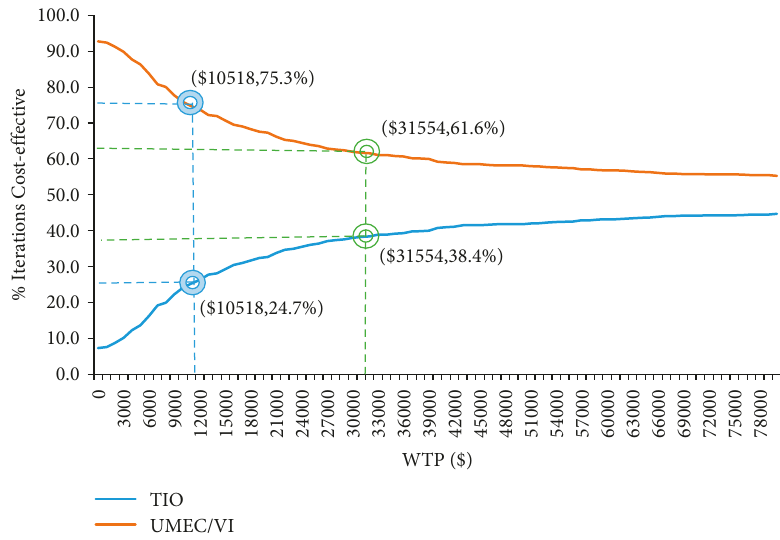
Figure 8: Cost-effectiveness acceptability curve for